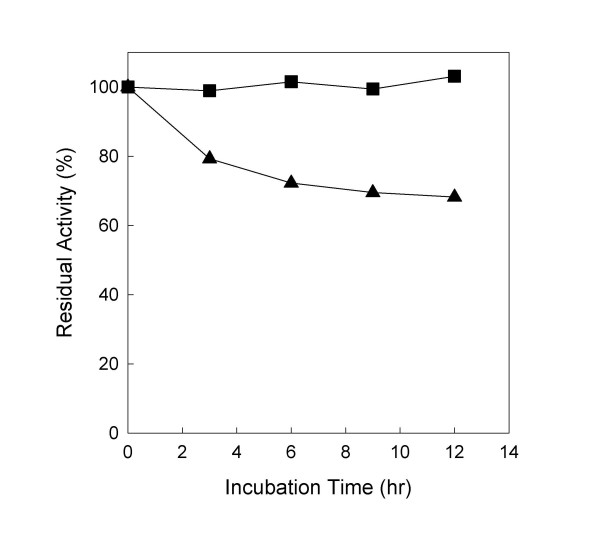
Stability of lipase displayed on the surface of P. putida GM730/pJHC13 cells (■) and free form lipase (▲) during incubation at 37°C in a two-phase water-isooctane reaction system. Residual lipase activities were measured spectrophotometrically with pNPP as a substrate and calculated by assuming the initial activity was 100%.